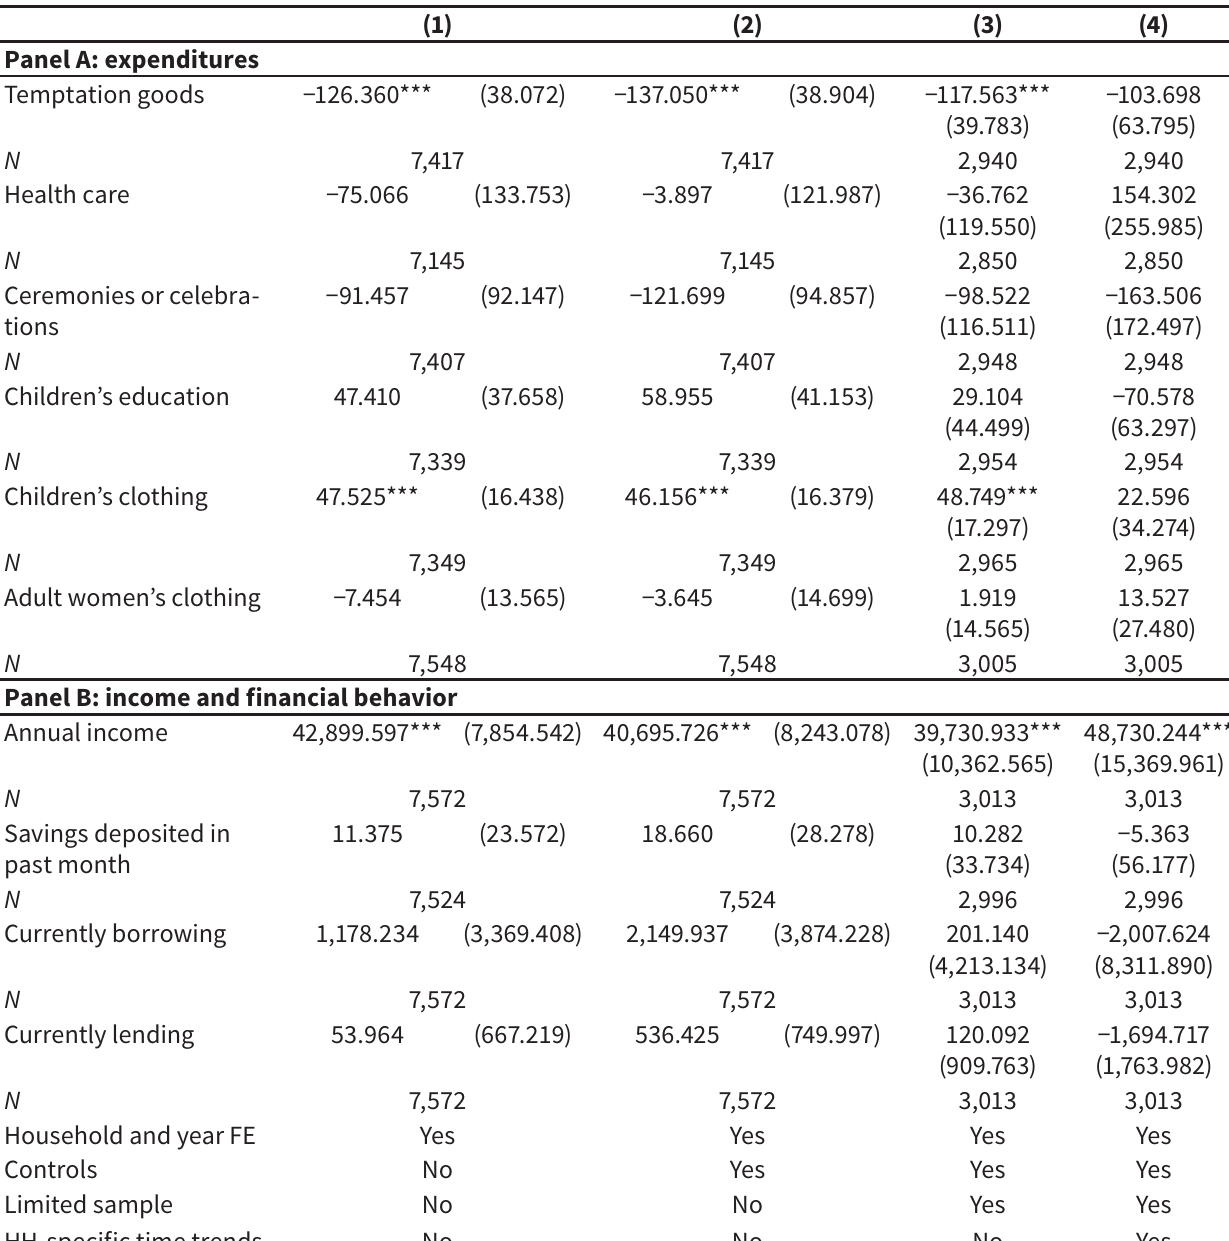
Changes in expenditures, income, and financial behavior as the husband’s migrant status changes – top-coded at the 95th